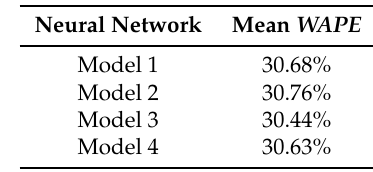
Table 6. Mean of the error values calculated using Equation (4) for fourteen test cases. WAPE , weighted absolute percentage error.